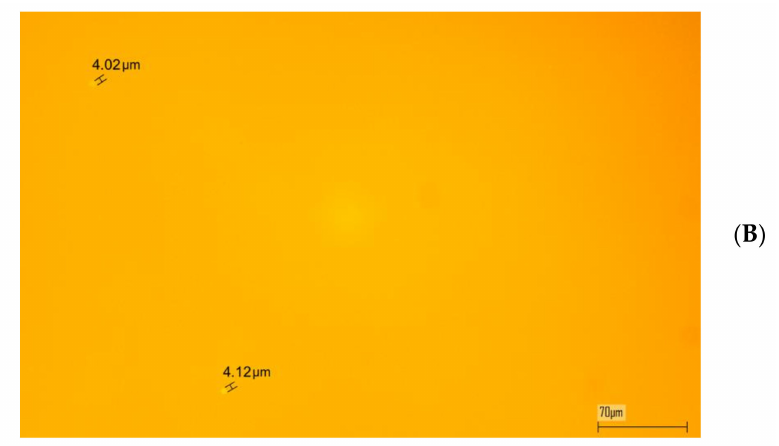
Figure 4. Fluorescent microscopy images of ( A ) poly(methylmethacrylate) (PMMA) and ( B ) PCHMA films doped with 1.4 wt% of LR. Scale bar = 70 µ m.